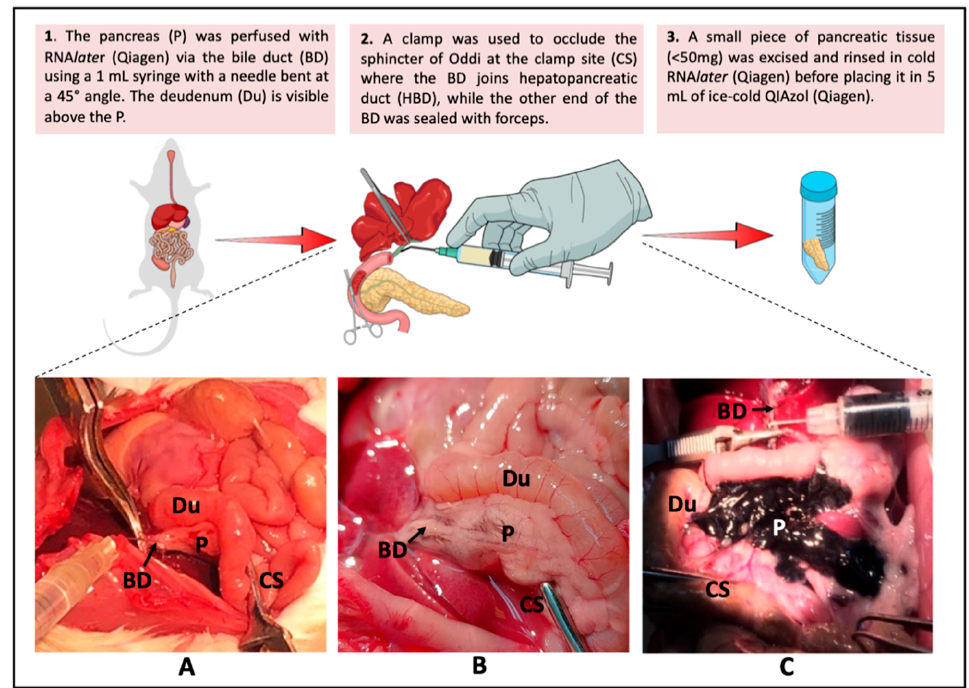
Figure 1. RNA later (Qiagen) injection into the bile duct (BD). ( A ) The liver was flipped over and pushed aside to expose the pancreas (P). ( B ) The BD was located and traced distally to its point of joining with the pancreatic duct (hepatopancreatic duct: HPD) at the sphincter of Oddi and occluded with a clamp at the clamp site (CS). RNA later (Qiagen) was injected by inserting a diabetic syringe needle into the BD. ( C ) To confirm the effectiveness of the RNA later (Qiagen) perfusion technique, Indian ink was injected into a test pancreas, showing good perfusion. The diagrams in the figure were generated using mindthegraph.com. Accessed on 10 December 2021.